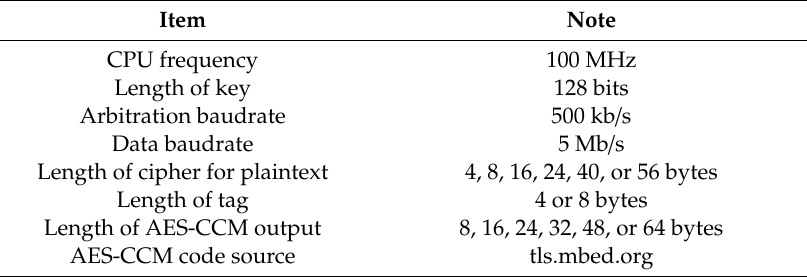
Table 8. Evaluation set-up of AES-CCM on a CAN FD bus. CPU—central processing